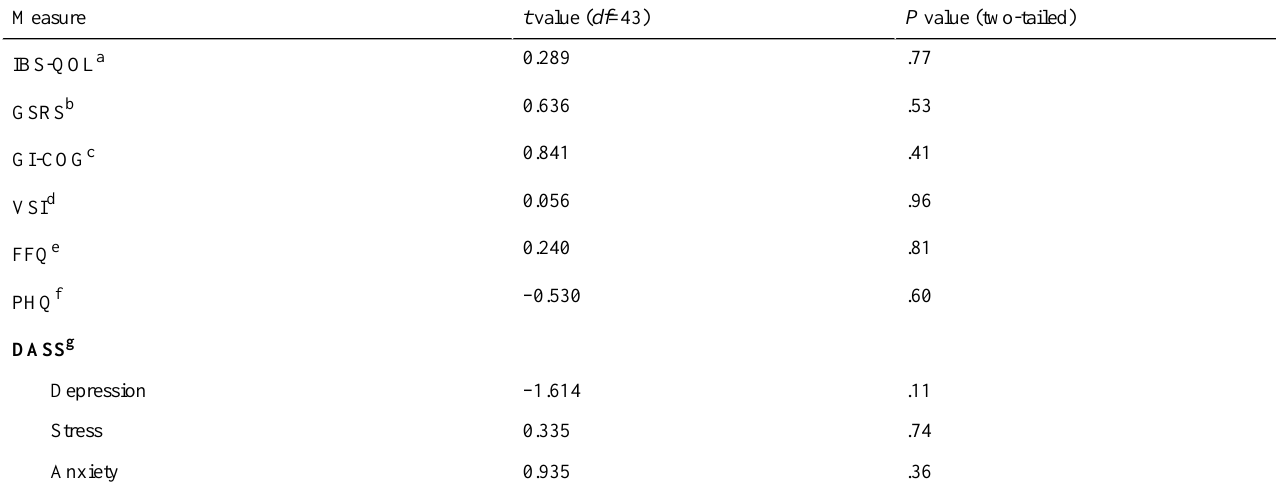
Table 6. Maintenance of gains from posttreatment to 3